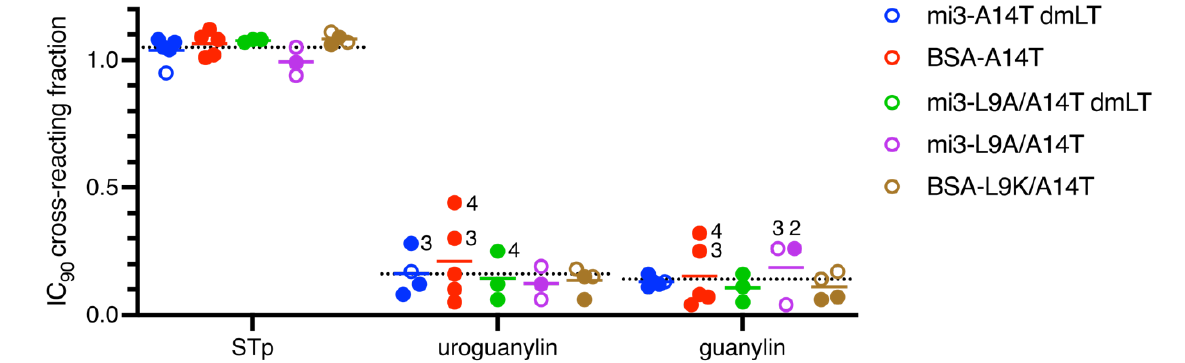
Figure 5. Immunological cross-reactivity of sera towards STp, uroguanylin, and guanylin assessed using competitive ELISAs. For each serum, four-parameter logistic regression was performed, and the 90% inhibitory concentration (IC 90 ) was calculated for native STh. These concentrations were then used to calculate the inhibition for each peptide relative to that of native STh. The plots show the cross-reactivity (vertical axis) for each peptide (horizontal axis) in each serum, and the solid lines depict mean cross-reactions within each serum group. For reference, the overall sera mean for each peptide are shown as dotted lines. Sera with neutralizing ability are shown as filled circles, and sera with an IC 90 cross-reacting fraction >0.2 are indicated by their serum number. Sera with anti-STh titers <4,000 could not be tested for cross-reactivity.